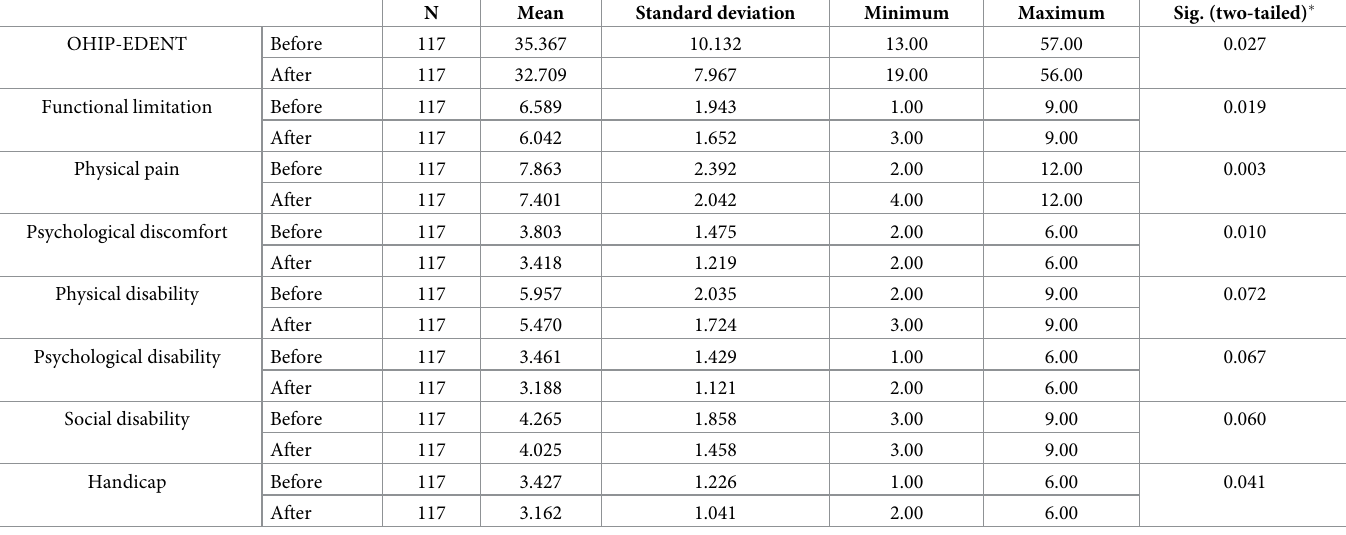
Table 2. The summary scores and scores of each domain ofthe OHIP-EDENT- B&H before and after corrections, adjustment and/or relining of complete dentures.